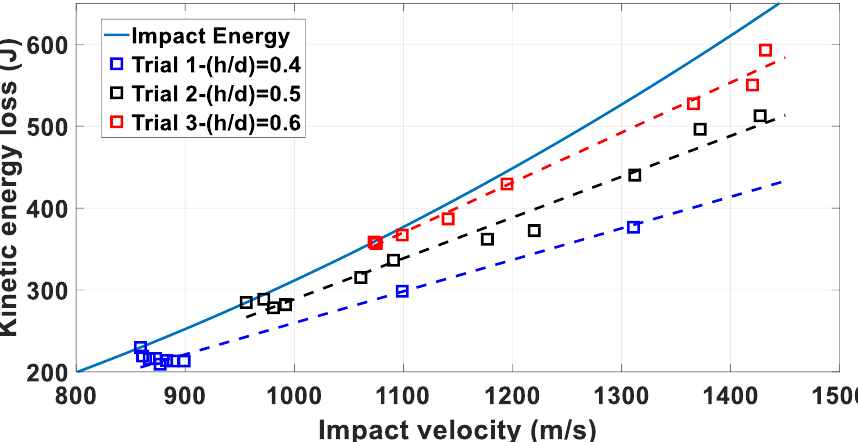
Figure 13. Kinetic energy loss for 5 mm fragments over impact velocity. The blue markers indicate the amout of kinetic energy lost impacting 2 mm plates; the black markers indicate the kinetic energy loss observed when impacting 2.5 mm plates and the red markers indicate the kinetic energy loss measured impacting 3 mm plates. The dashed lines are linear curve fit obtained from the experimental data.